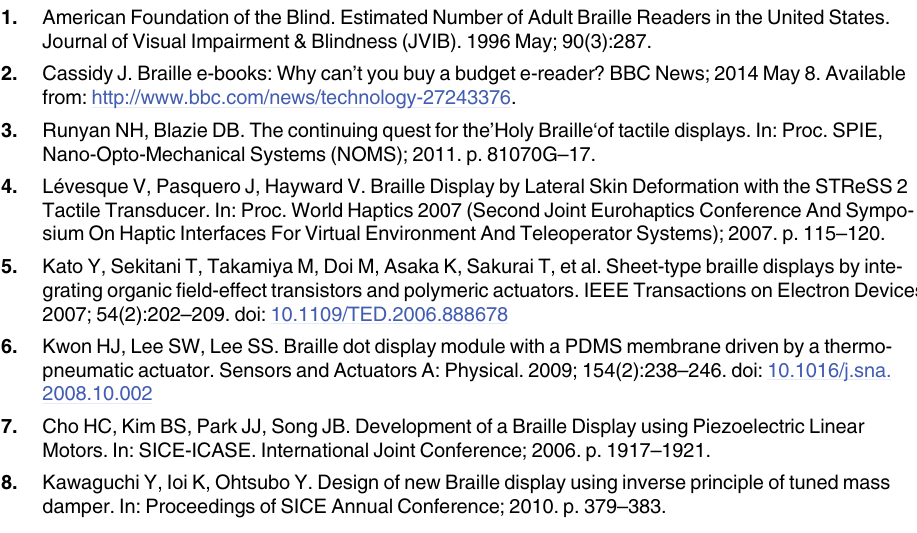
S1 Fig. Geometry of curve path